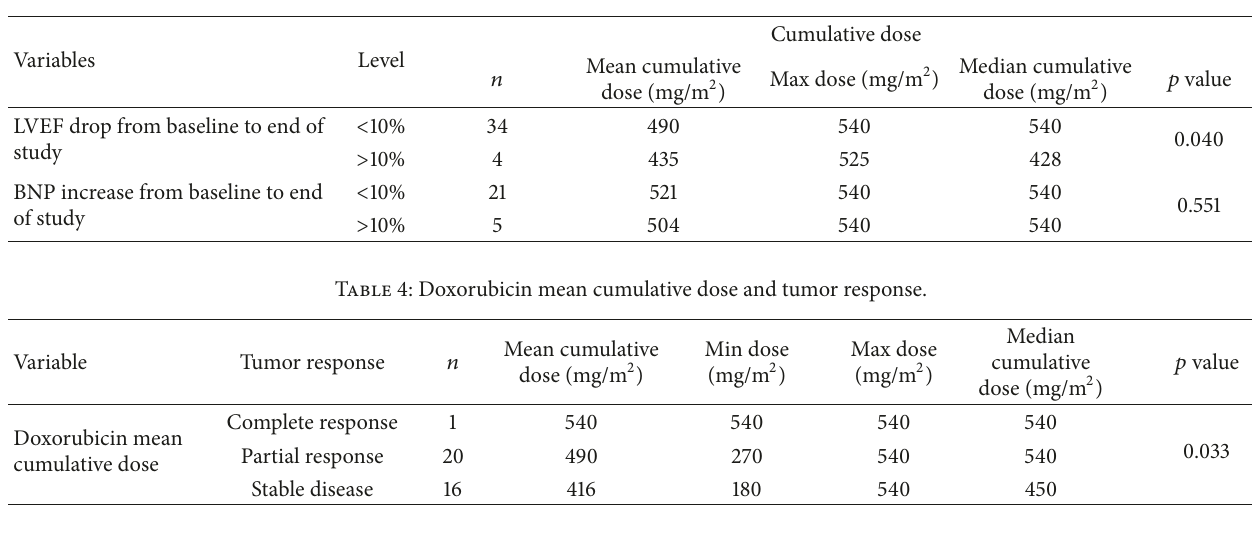
Table 3: Associations between mean doxorubicin cumulative dose and changes in LVEF and BNP.